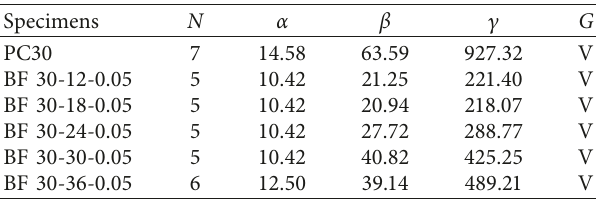
Table 6: Crack resistance indices of test specimens with different fiber